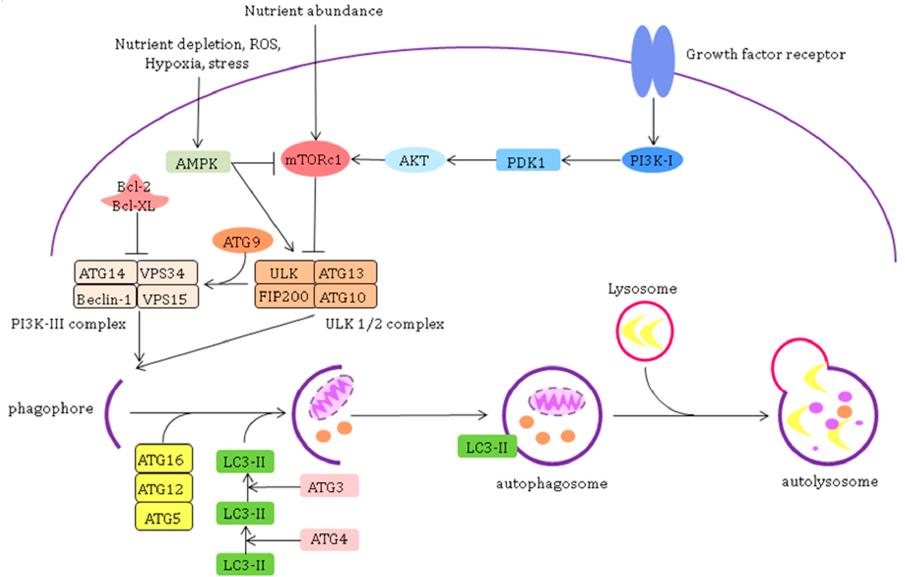
Figure 3. Pathways of macro-autophagy. Initiation of autophagy is regulated by mTORC1 (mammalian target of rapamycin complex 1) and AMPK (AMP-activated kinase). Together, they regulate the activity of the ULK1 / 2 complex consisting of ULK1 / 2 (Unc-51 like autophagy activating kinase), FIP200 (FAK family kinase interacting protein of 200 kDa) and the autophagy related proteins (ATG) ATG13 and ATG10. Activation of mTOR leads to the phosphorylation of this complex and inhibition of autophagy (for instance, through the phosphatidylinositol 3-kinase (PI3K) / Protein kinase B (AKT) or the mitogen-activated protein kinase (MAPK) / extracellular signal–regulated kinase (Erk) 1 / 2 signalling pathway) whereas activation of AMPK activates autophagy. AMPK, activated upon intracellular AMP increase, is able to activate autophagy by inhibition of the mTORC1 through dissociation of mTORC1 from ULK1 / 2 allowing ULK1 / 2 to be activated. AMPK, is also able to initiate autophagy in a direct way by phosphorylation of ULK1 / 2 forming the ULK1 / 2-complex.Another complex involved in the initiation is the autophagy inducible beclin-1 complex (or class III PI3K complex) which consists of Vps34 (phosphatidylinositol 3-kinase), beclin-1 (a BH3 only domain protein member of the Bcl-2 family), vps15 and ATG14. This complex is activated by the ULK-1 complex and inhibited by Bcl-2 and Bcl-XL. The ULK1 / 2 and class III PI3K complexes join to form the phagopore and eventually the autophagosme. This process is mediated by the ATG5-ATG12-ATG16 complex and the formation of phosphatidylethanolamine-conjugated Light Chain (LC) 3 (LC3-II) facilitating elongation of the bilipid membrane to form a closed autophagosme. The autophagosome fuses with a lysosome and the content of the autolysosome is degenerated and the components are released to be reused to synthesise new proteins or to function as an energy source for the cell. PDK-1: pyruvate dehydrogenase